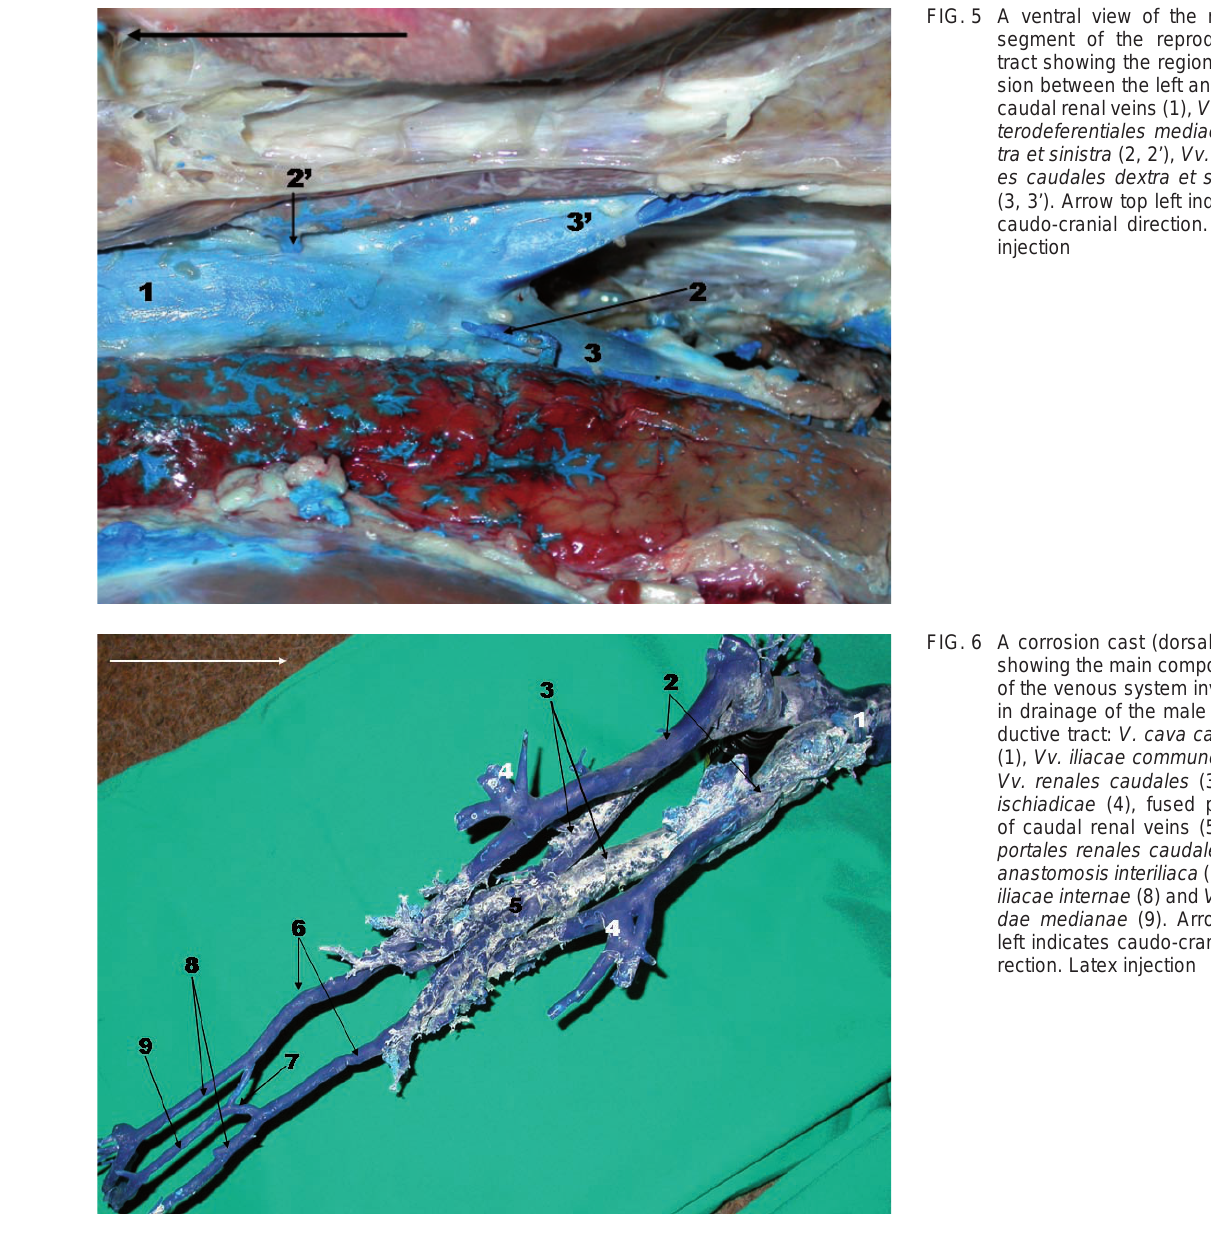
FIG. 5 A ventral view of the middle seg ment of the reproductive tract showing the region of fu- sion between the left and right caudal renal veins (1), Vv. ure- terodeferentiales mediae dex- tra et sinistra (2, 2’), Vv. renal- es caudales dextra et sinistra (3, 3’). Arrow top left indicates caudo-cranial direction. Latex